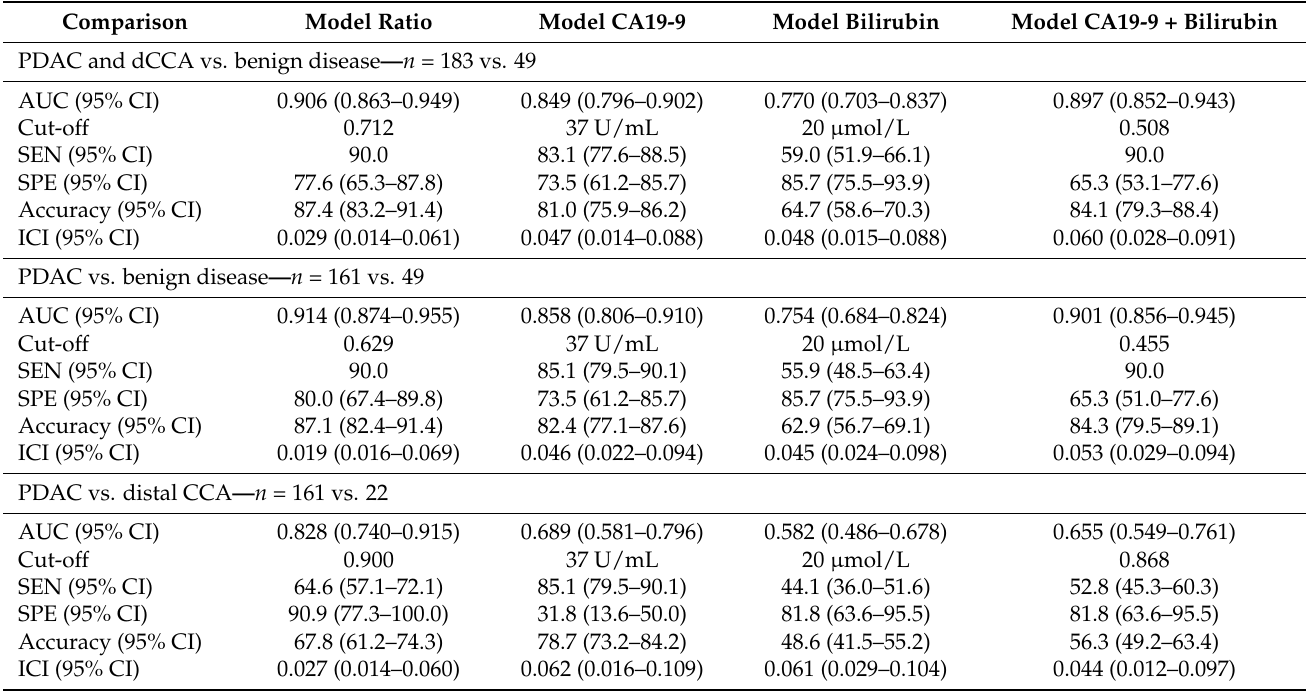
Table 4. Comparisons of the four models in the malign vs. benign, PDAC vs. benign and PDAC vs. dCCA